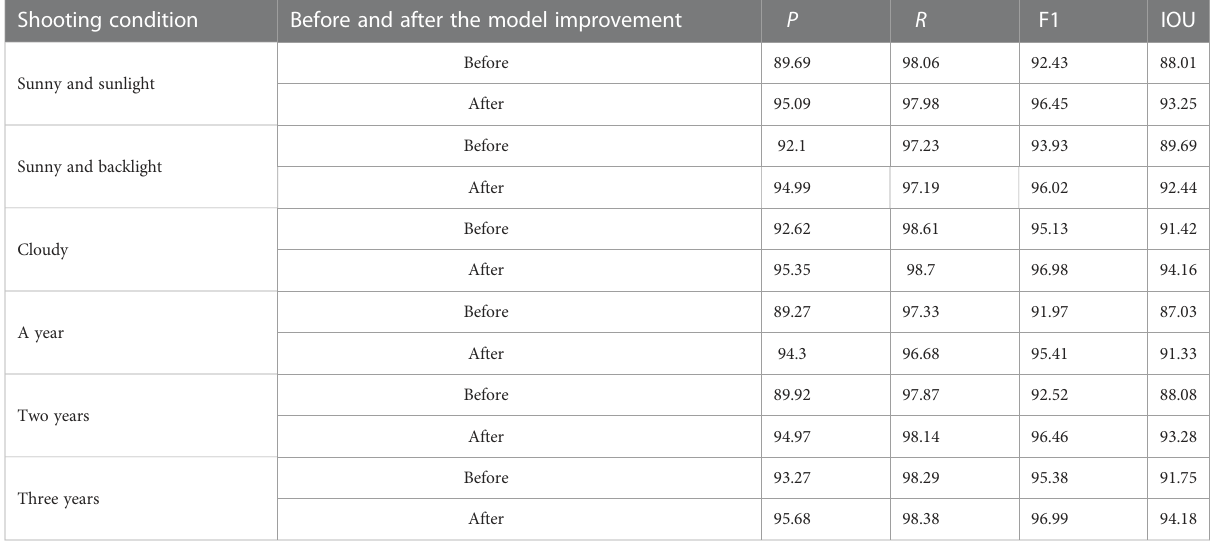
TABLE 3 Detection results before and after model improvement under different shooting